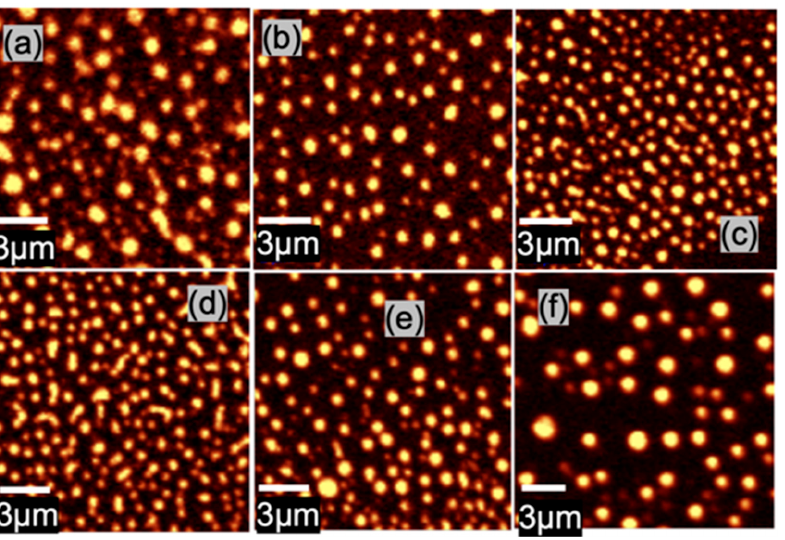
Figure 2. MoS 2 A g1 peak Raman maps of MoS 2 N-donuts and N-discs/graphene samples that were synthesized with different precursor solution concentrations of ( a ) 0.06 wt%, ( b ) 0.10 wt%, ( c ) 0.20 wt%, ( d ) 0.26 wt%, ( e ) % 0.32 wt%, and ( f ) % 0.40 wt%.